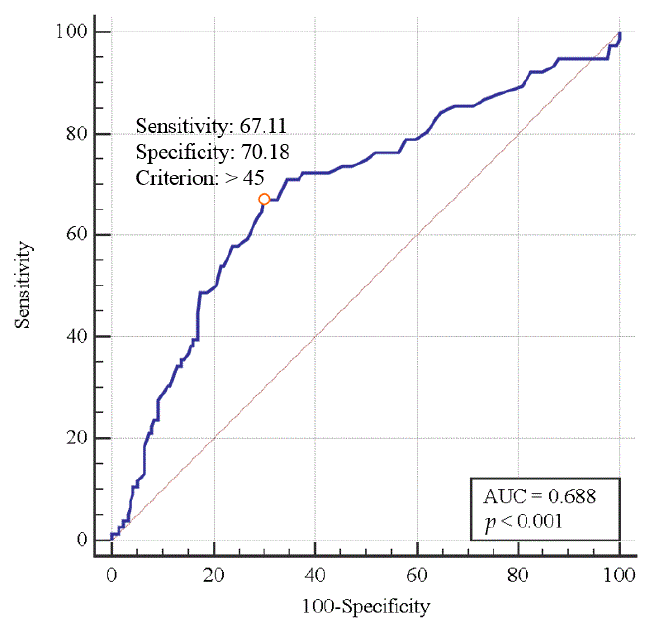
Figure 2. Diagnostic performance (receiver operating characteristic curve) of serum ammonia level for predicting the incidence of postoperative acute kidney injury in liver transplant patients. Table 5. Logistic regression analysis in patients undergoing liver The univariate analysis showed that ammonia levels (>45 μ g/dL), age, model for end-stage liver disease score, preoperative serum hemoglobin level, total fluid intake, and transfused packed red blood cells were related to postoperative AKI after LT, as shown in Table 5. The multivariable analysis revealed that preoperative ammonia levels (>45 μ g/dL; p < 0.0001) and age ( p = 0.034) were independent risk factors for postoperative AKI after LT.